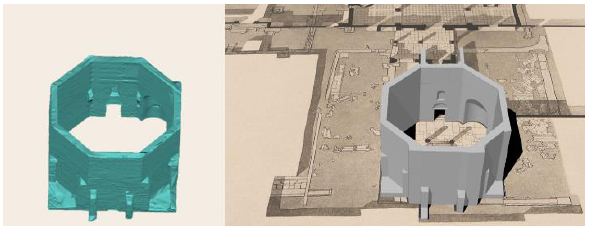
Figure 5. View of the final point cloud from the top (left) and from the southwest side (right) of the Baptistery of Aquileia POINT CLOUD